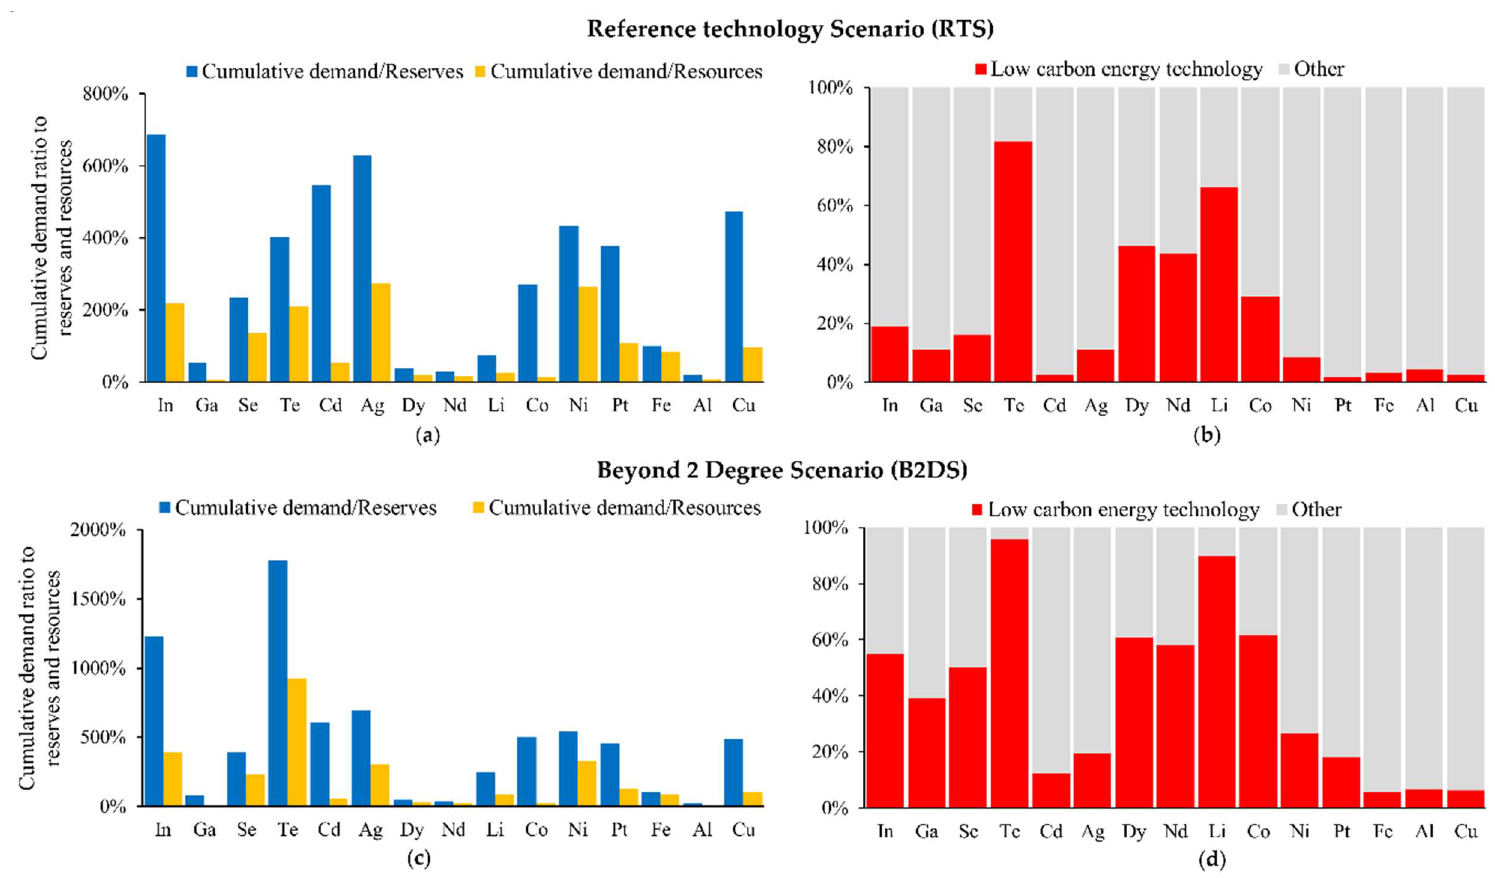
Figure A2. Complete estimated results in each scenario. ( a , c ) Cumulative demand from 2016 to 2060 compared to the reserves and resources. ( b , d ) Breakdown of end-uses of cumulative demand from 2016 to 2060.